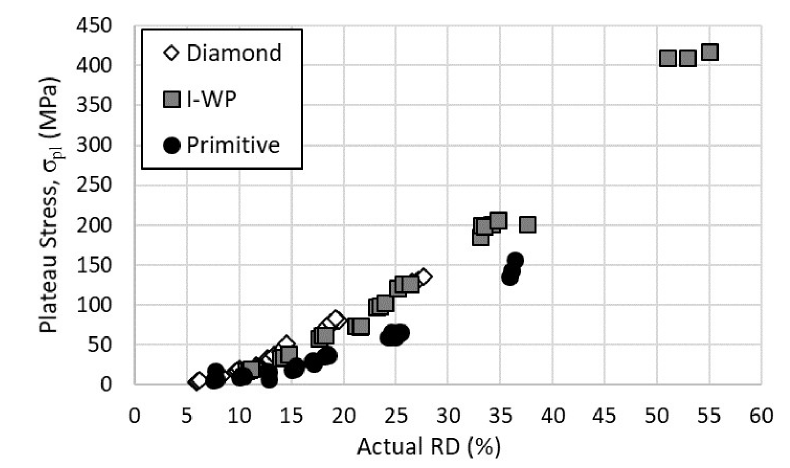
Figure 8. Plateau stress versus actual relative density of Lattice Designs.